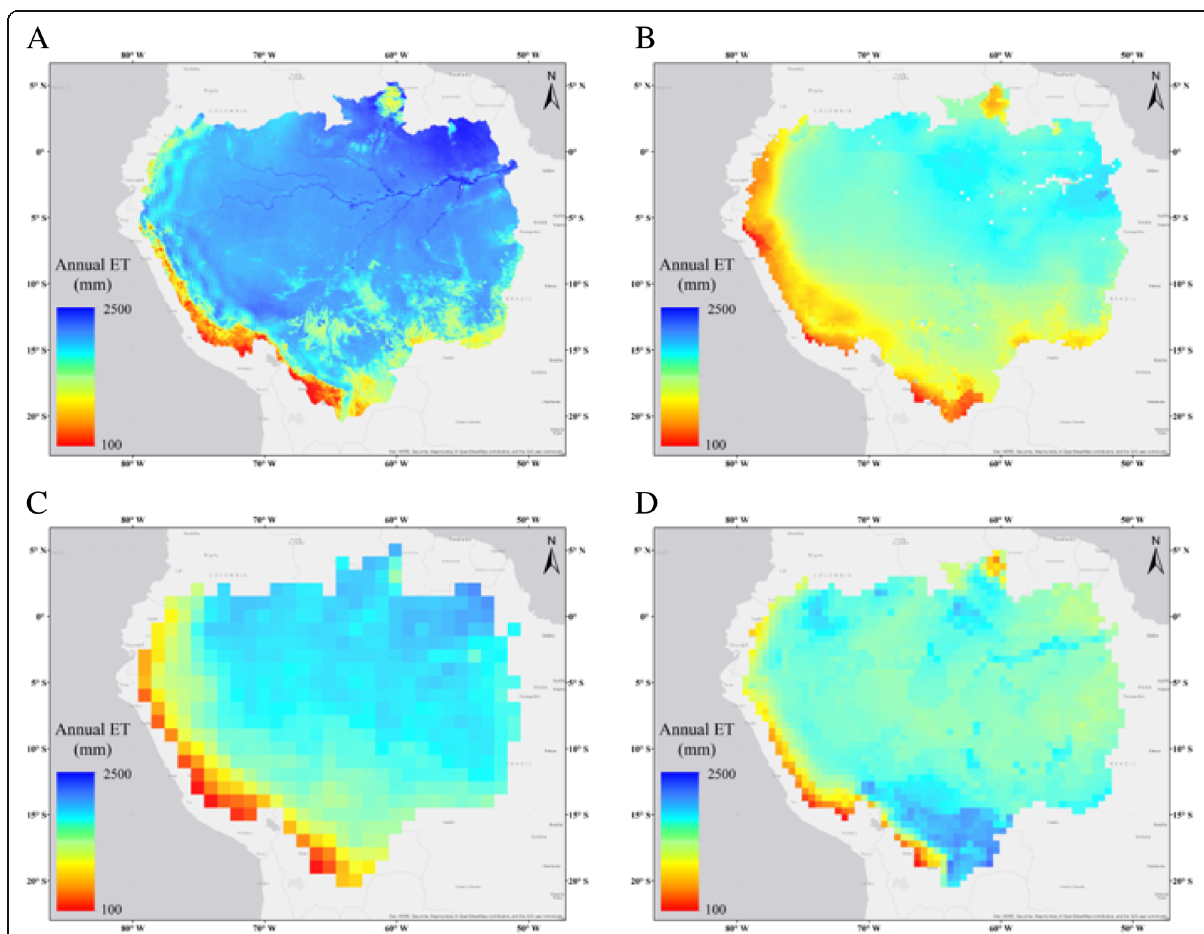
Fig. 7 Comparison of mean annual ET in the Amazon basin from four ET products: a ET-Amazon, b WACMOS-ET, c LandFlux-EVAL, and d